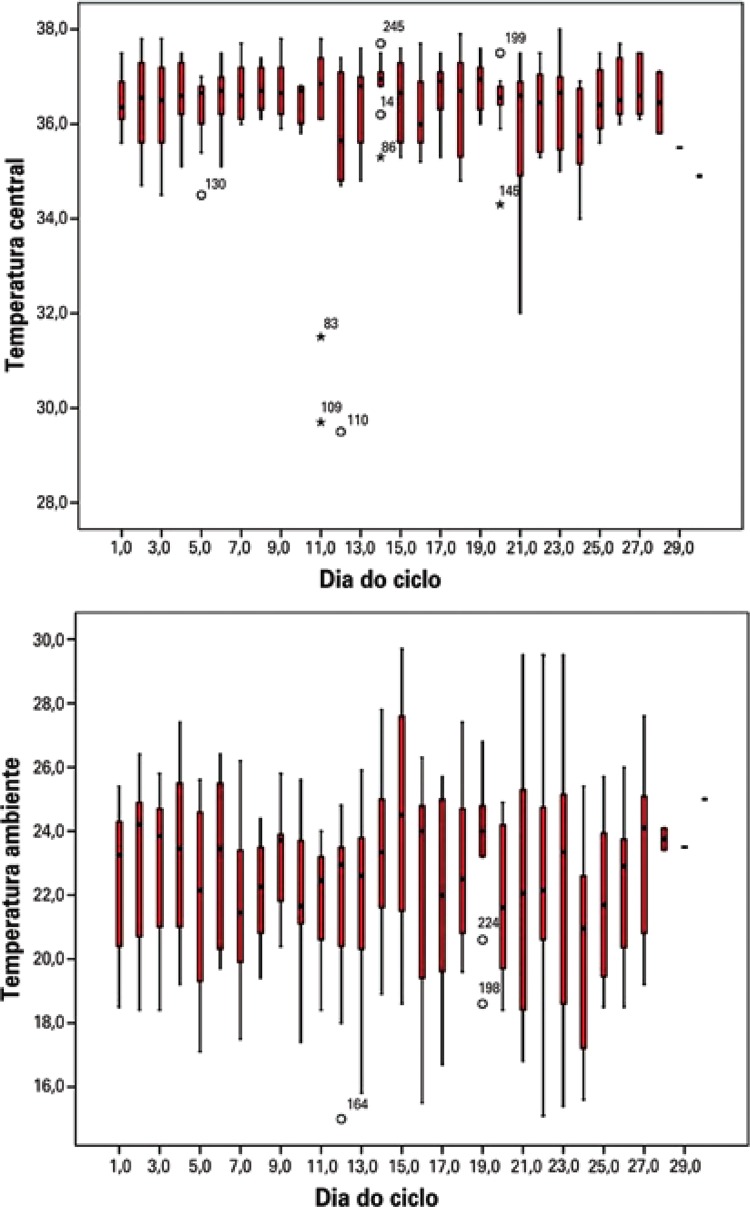
Variabilidade das temperaturas central e ambiente durante ciclo menstrual. A temperatura central variou 4ºC e a ambiente 12,1ºC